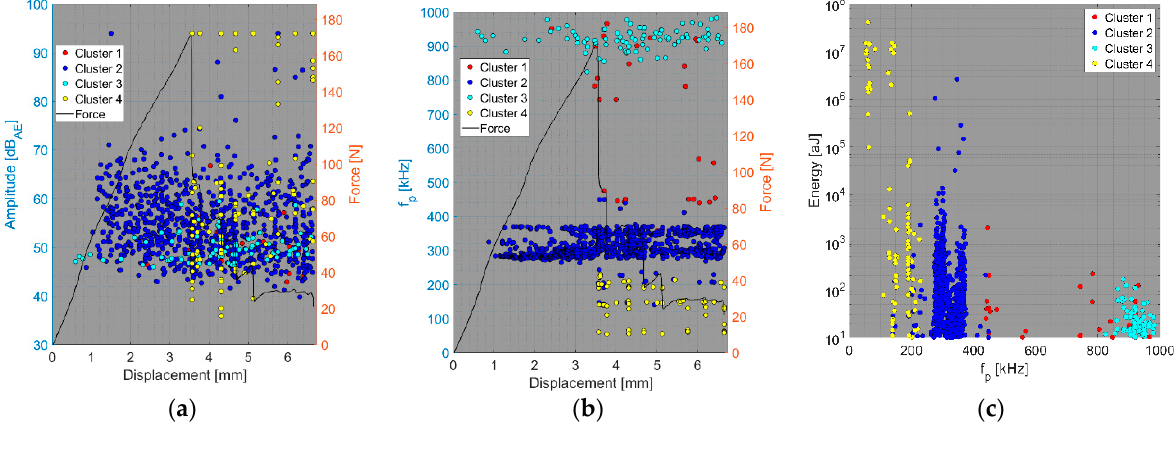
Figure 18. Clustering results for a CPCT representative sample using a spectral clustering algorithm and secondary filtering using a partial power variable (Fujicera 1045S dataset).